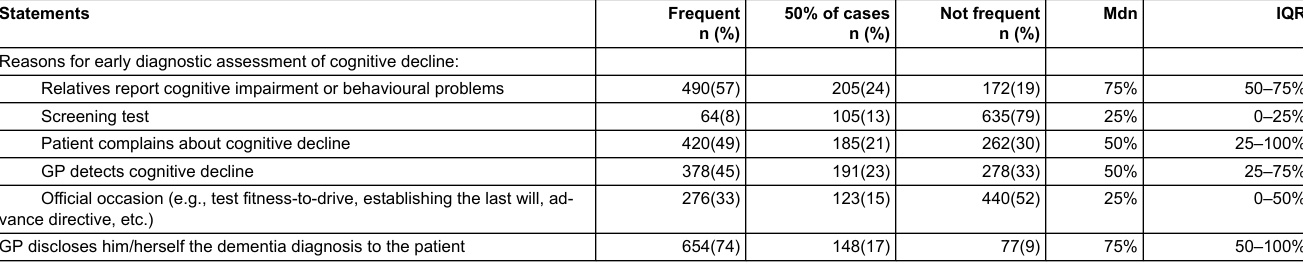
Table S1: Frequency of statements about diagnostic assessment and disclosure.